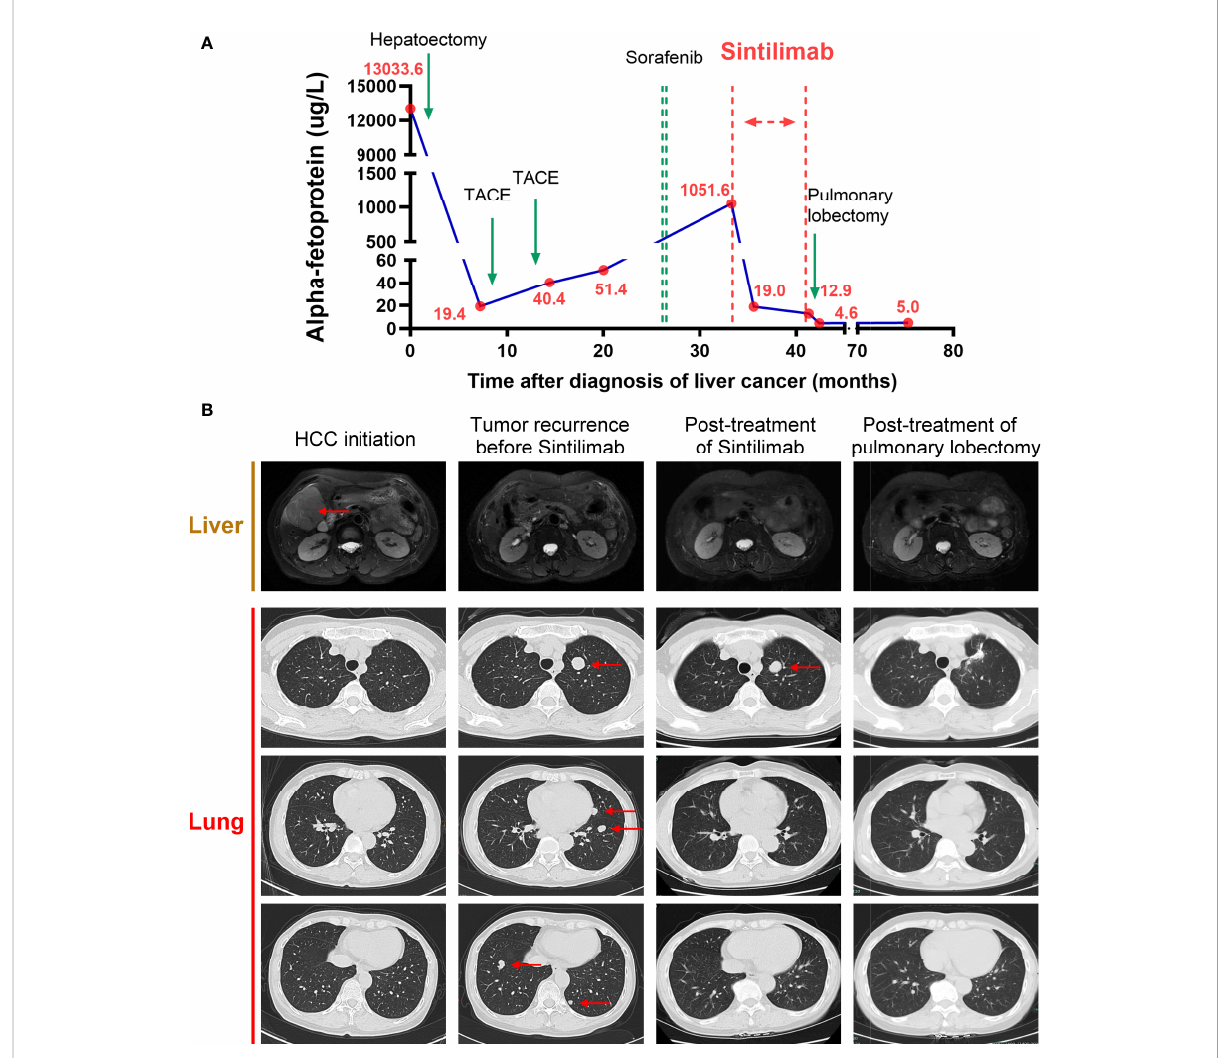
FIGURE 1 Course of the patient ’ s treatments. (A) Timelines of main treatments and changes in a -fetoprotein (AFP) levels during each period. (B) Representative imaging assessments during each period, including hepatic magnetic resonance (T2-weighted) and pulmonary computerized tomography (CT) in three different sections. Red arrows indicate the